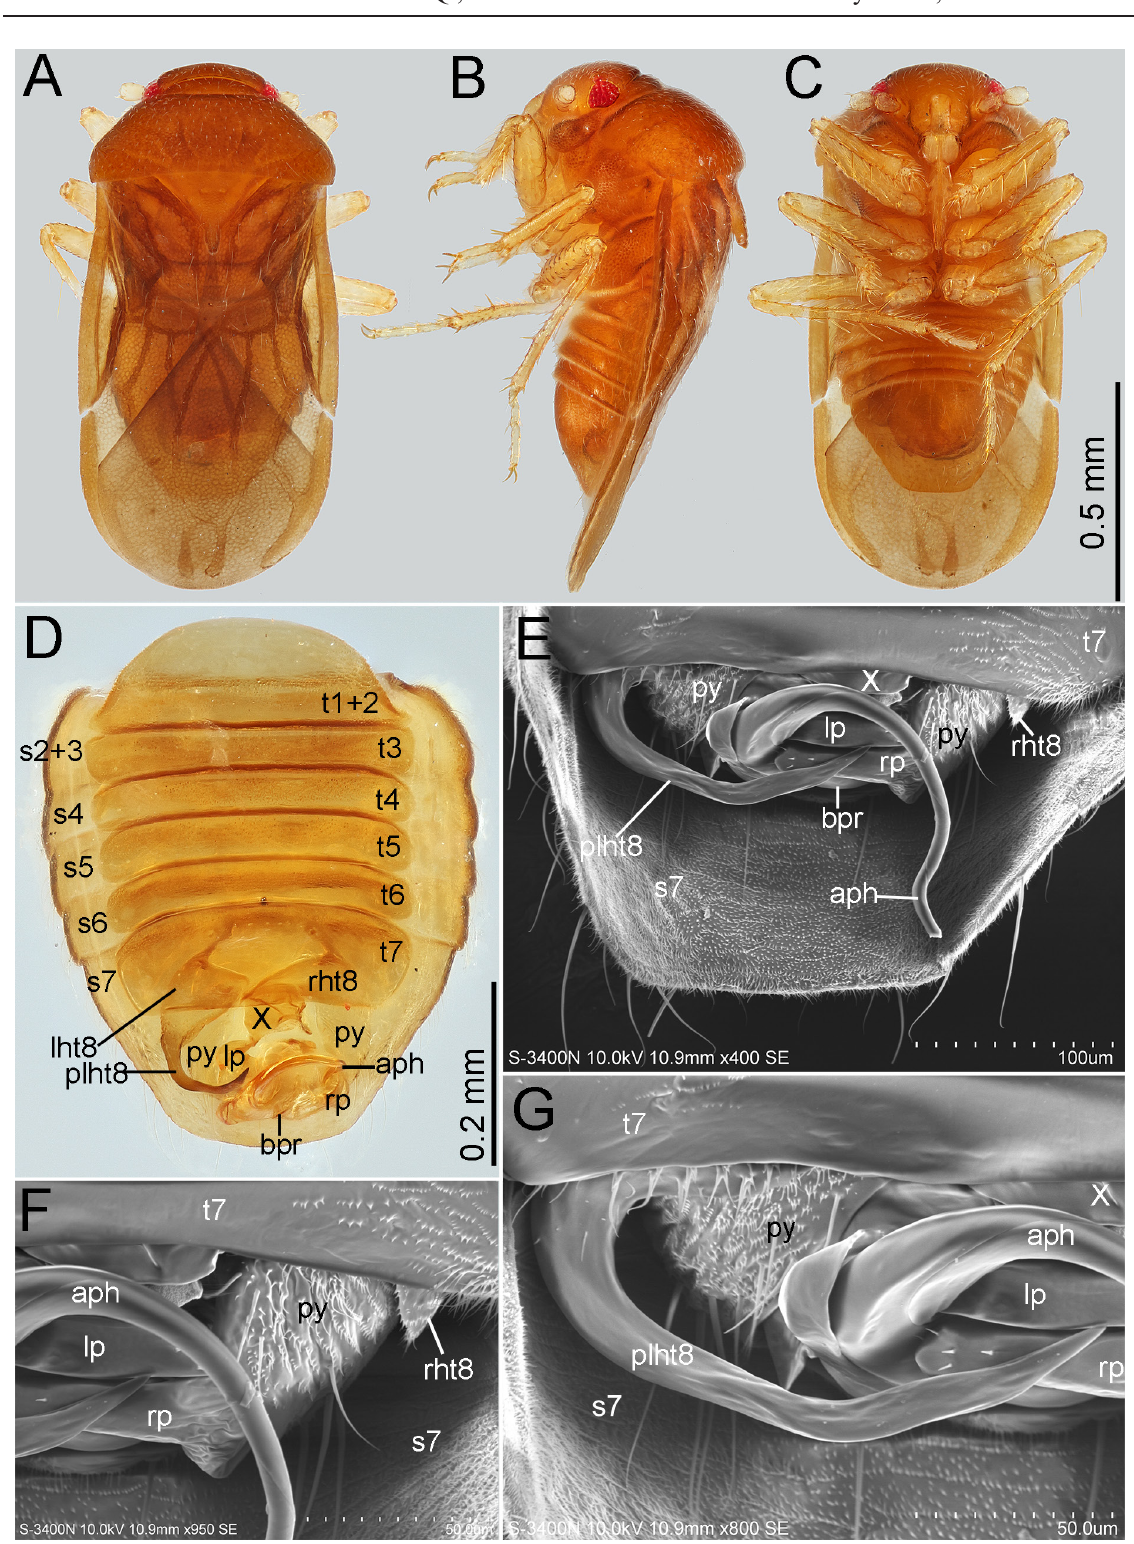
Fig. 17. Kokeshia redeii sp. nov. A‒C . Habitus, holotype, ♂ (SYSBM). A . Dorsal view. B . Lateral view. C . Ventral view. D . Pregenital abdomen and genitalia, dorsal view, paratype, ♂ (SYSBM). E‒G . Scanning electron micrographs of genitalia, paratype, ♂ (SYSBM). E . Dorsal view. F . Right side, dorsal view. G . Left side, dorsal view. Abbreviations: see Material and